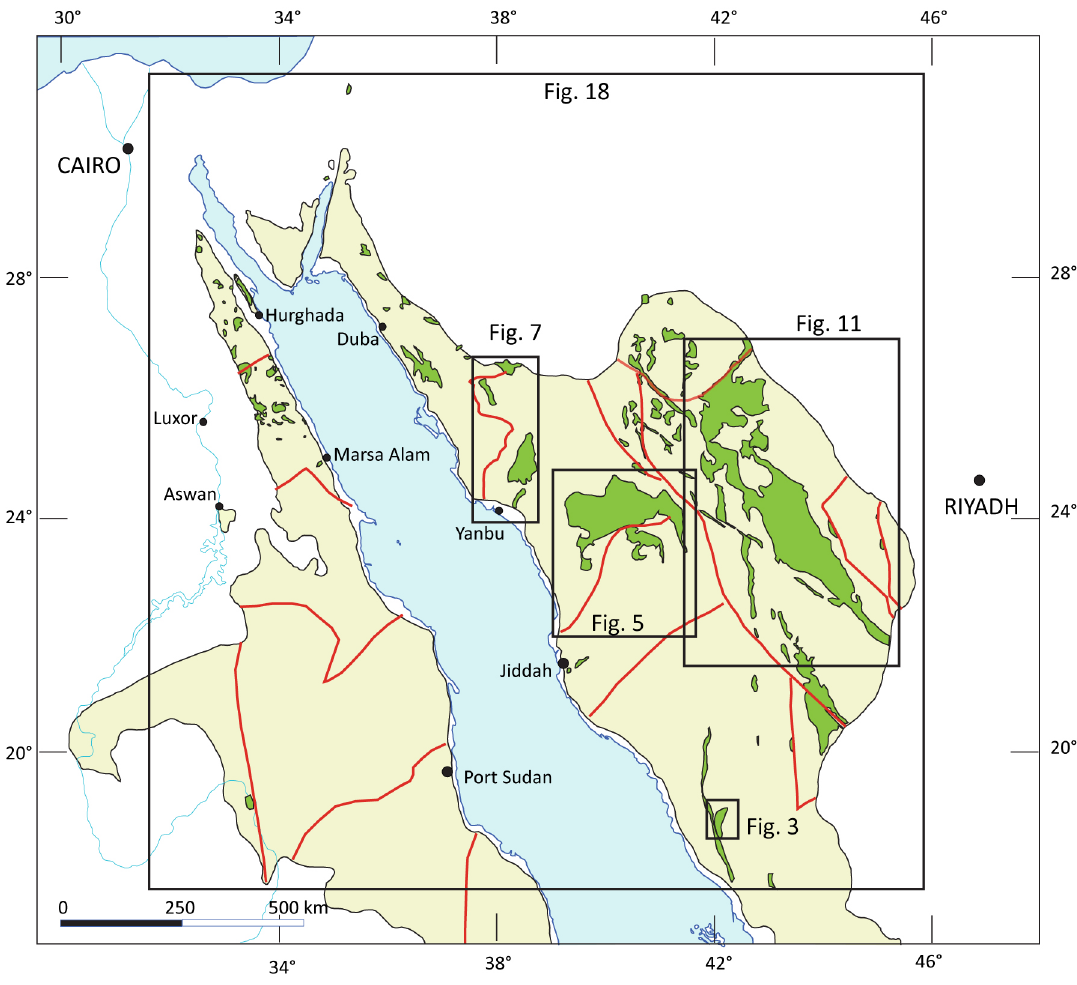
Figure 2. Index of regions discussed in the